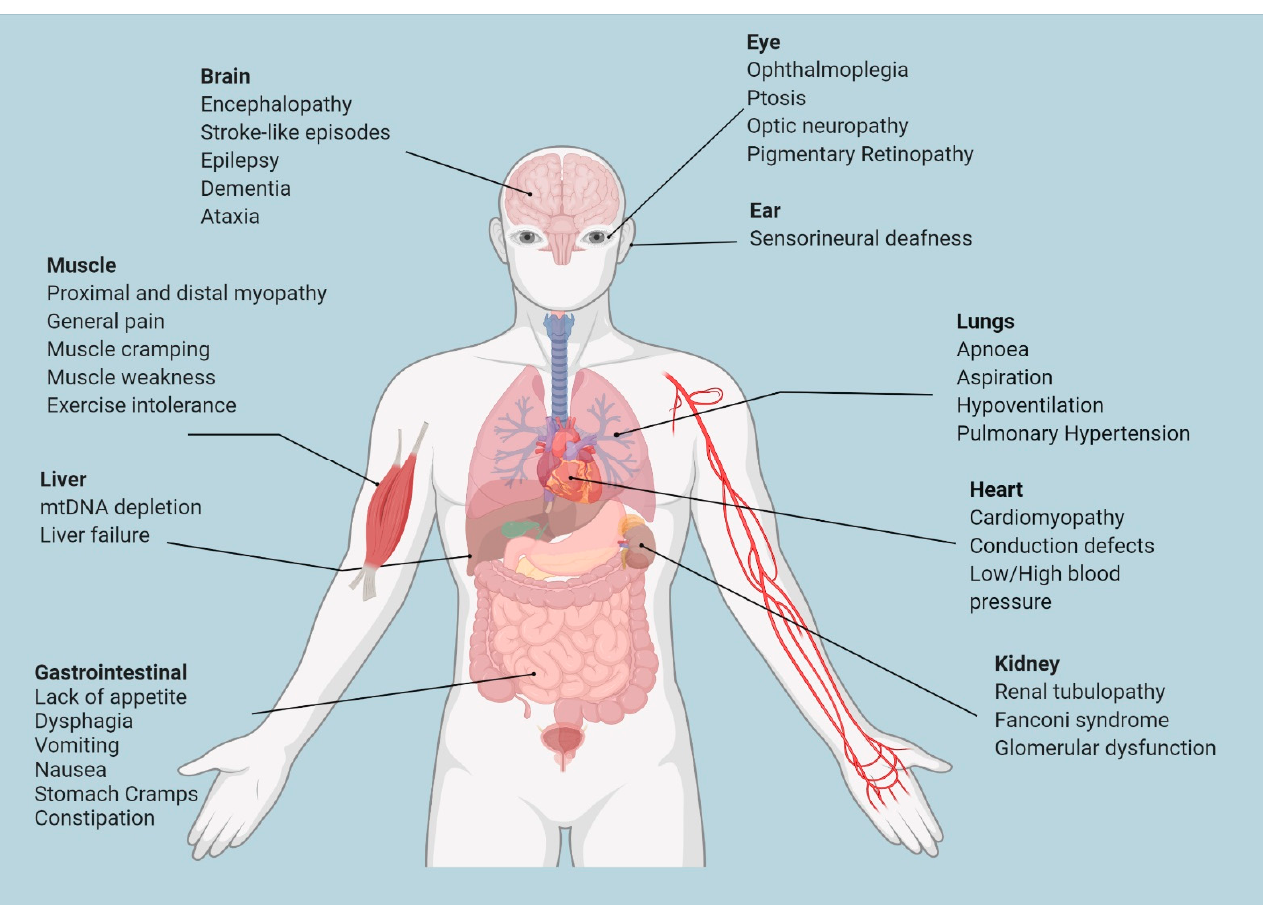
Figure 1. Clinical features of mitochondrial disorder: MDs are caused by oxidative phosphorylation (OXPHOS) failure and display high biochemical, genetic, and clinical complexity, which complicate the prognosis and the development of therapeutic solutions. Adapted from “Adult male” by BioRender.com (accessed on 5 April 2022). Retrieved from https://app.biorender.com/biorender- templates (accessed on 3 June 2022).